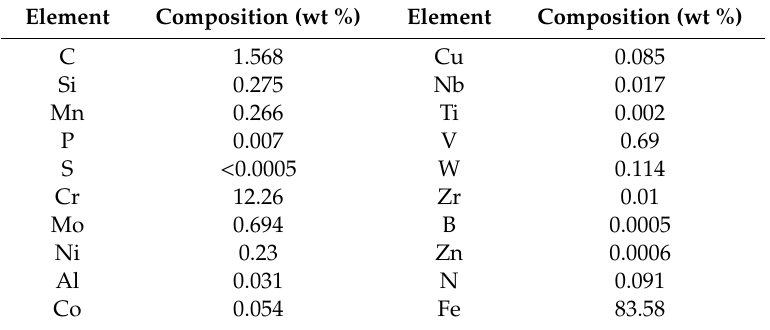
Table 2. Chemical Composition Determined Using a SPECTROMAXx Stationary Metal Analyzer in Weight Percent of the AISI